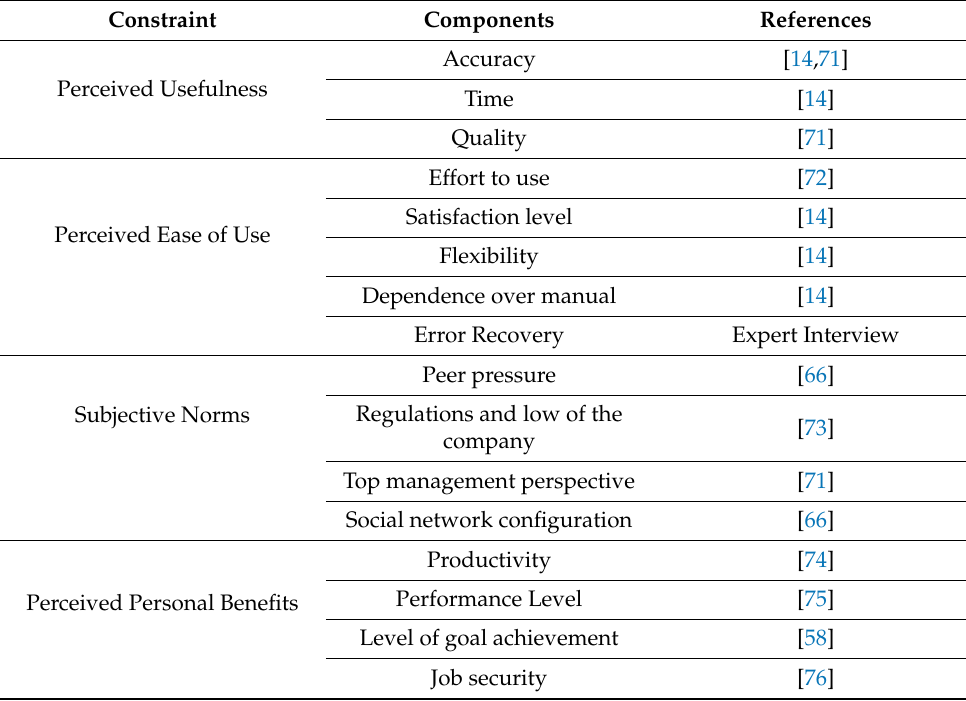
Figure 1. The conceptual model for digitalization of the construction industry. Table 5. Deriving factors to extend the conceptual